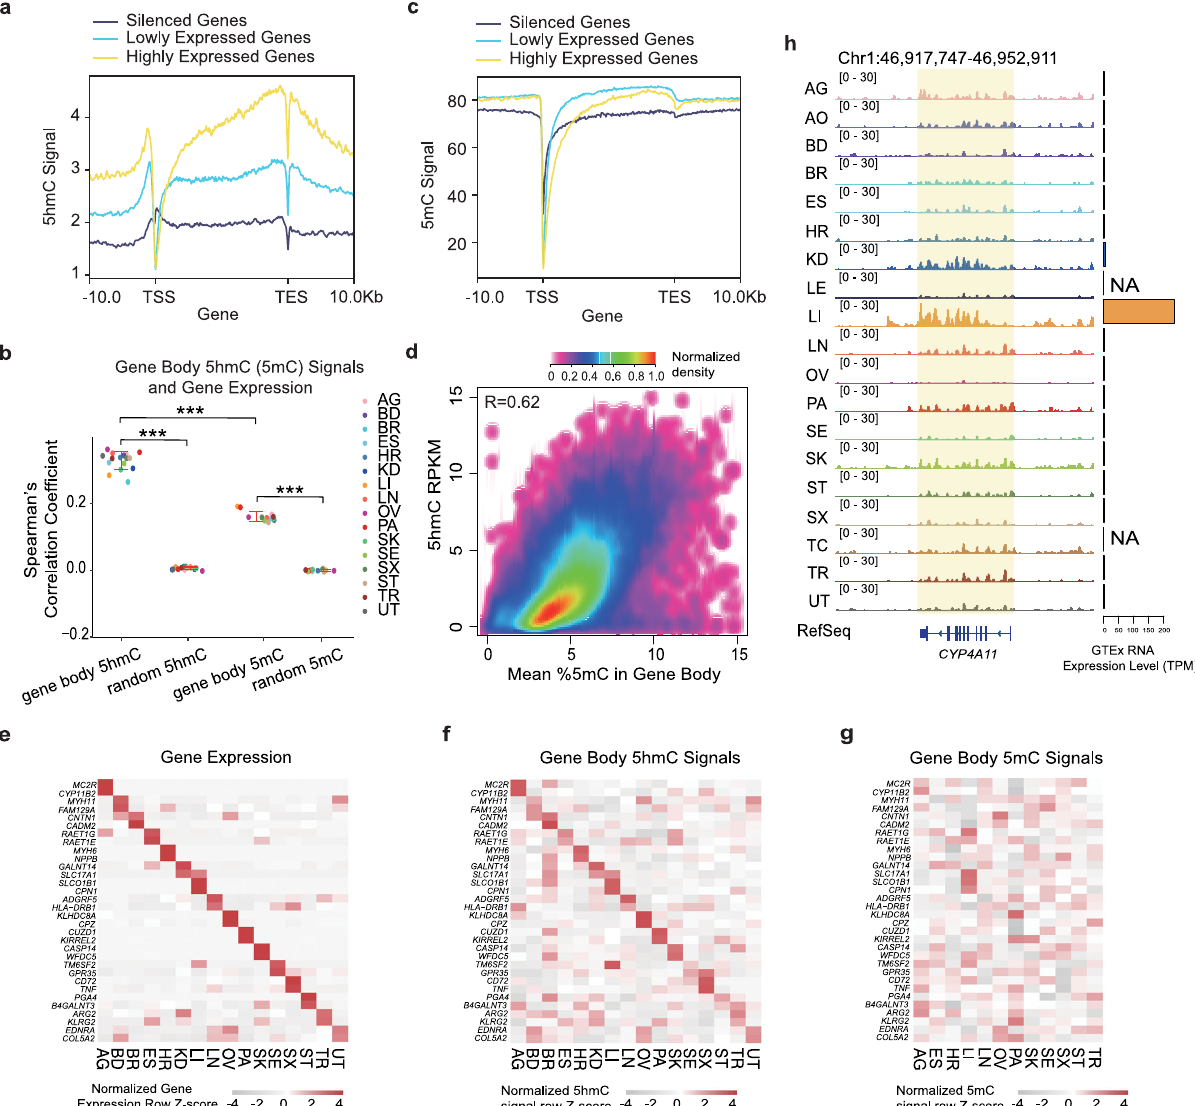
Fig. 3 Gene body 5hmC correlates well with gene expression in human tissues. a 5hmC pro fi les of genes expressed at high (yellow), low (cyan), and silenced (blue) levels in heart tissue. b Spearman ’ s correlation of gene body 5hmC (5mC) signals and gene expression levels. Random regions were selected as controls (***represents P -value < 0.0001; two-side Mann – Whitney U -test; n 5hmC = 16 tissue types; n 5mC = 12 tissue types; 5hmC vs. random P - value: 3.32 × 10 − 9 ;5mC vs. random P -value: 7.396 × 10 − 7 5hmC vs. 5mC P -value :6.57 × 10 − 8 ; red lines represent the fi rst and third quantiles). c 5mC pro fi les of genes expressed at high (yellow), low (cyan) and silenced (blue) levels in heart tissue. d Scatter plot showing the correlation of 5mC and 5hmC signals at gene bodies. e Heatmap displaying the expression levels of tissue-speci fi c marker genes. Gene expression of matched tissue samples downloaded from the GTEx project. f , g Heatmap displaying normalized gene body 5hmC ( f ) and 5mC ( g ) signals of tissue-speci fi c marker genes (order of rows as in e ). 5mC data downloaded from ENCODE. h IGV visualization of the 5hmC signals at the gene body of CYP4A11 and surrounding regions. Gene expression levels of the gene in different tissues are shown on the